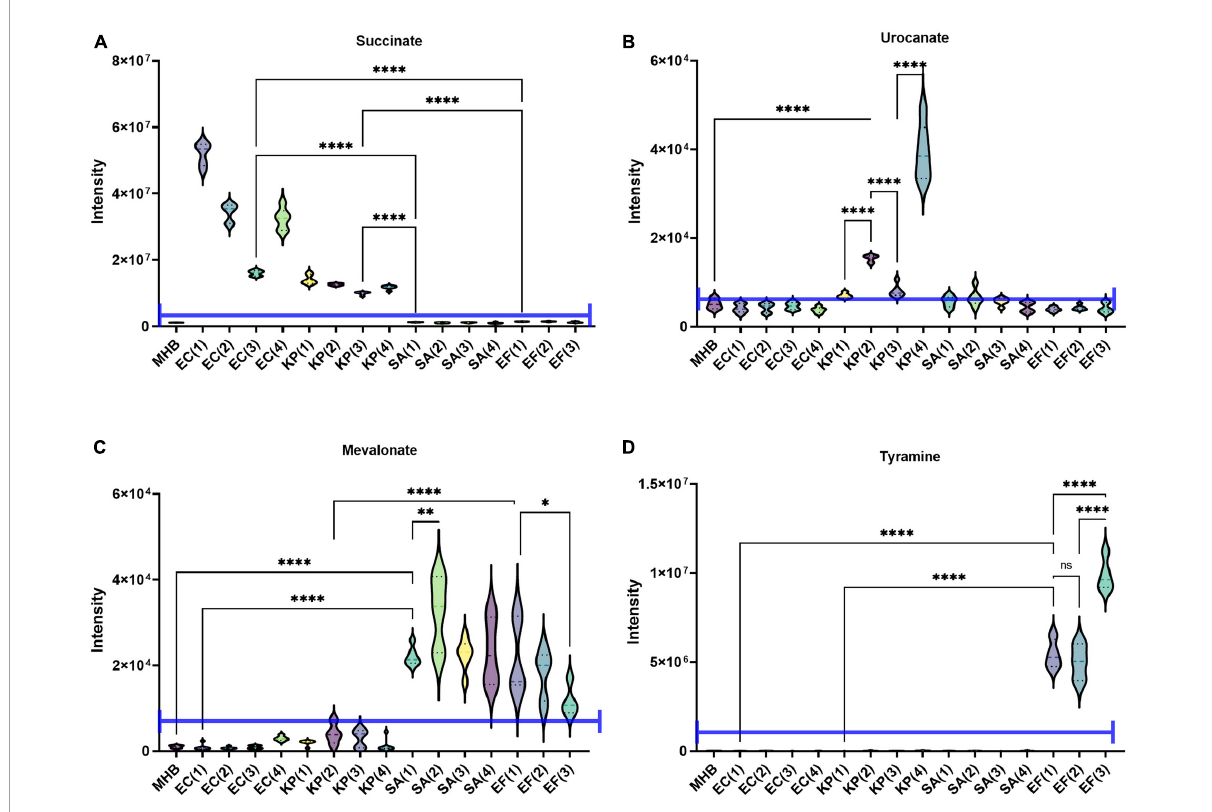
FIGURE4 Demonstration of the MCD as a platform for identifying microbes via their metabolic boundary fluxes. Escherichia coli (EC 1, 2, 3, 4), Klebsiella pneumoniae (KP 1, 2, 3, 4), Enterococcus faecalis (EF 1, 2, 3), and Staphylococcus aureus (SA 1, 2, 3, 4) were identified based on the intensity